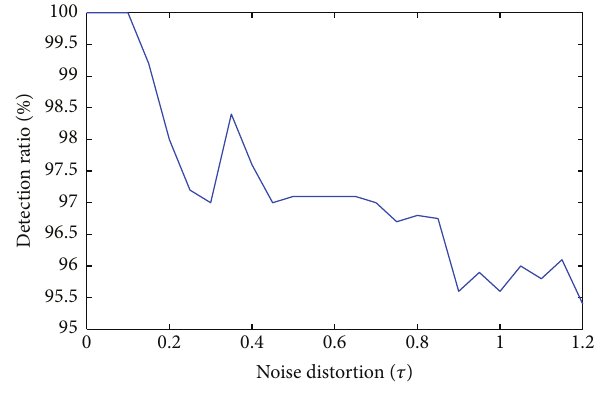
Figure 1: Resistance to noise distortion.